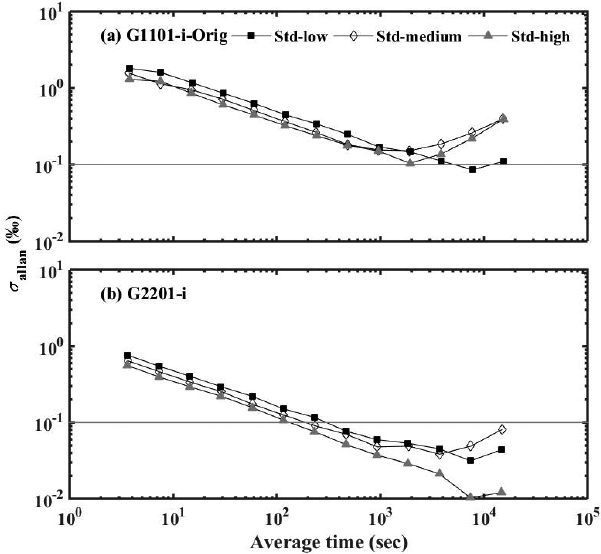
Figure 2. Allan deviation of the δ 13 C at endpoint for the (a) G1101- i before upgradation (G1101-i-original) and (b) G2201-i analyzers with three different CO 2 concentrations with same δ 13 C standard